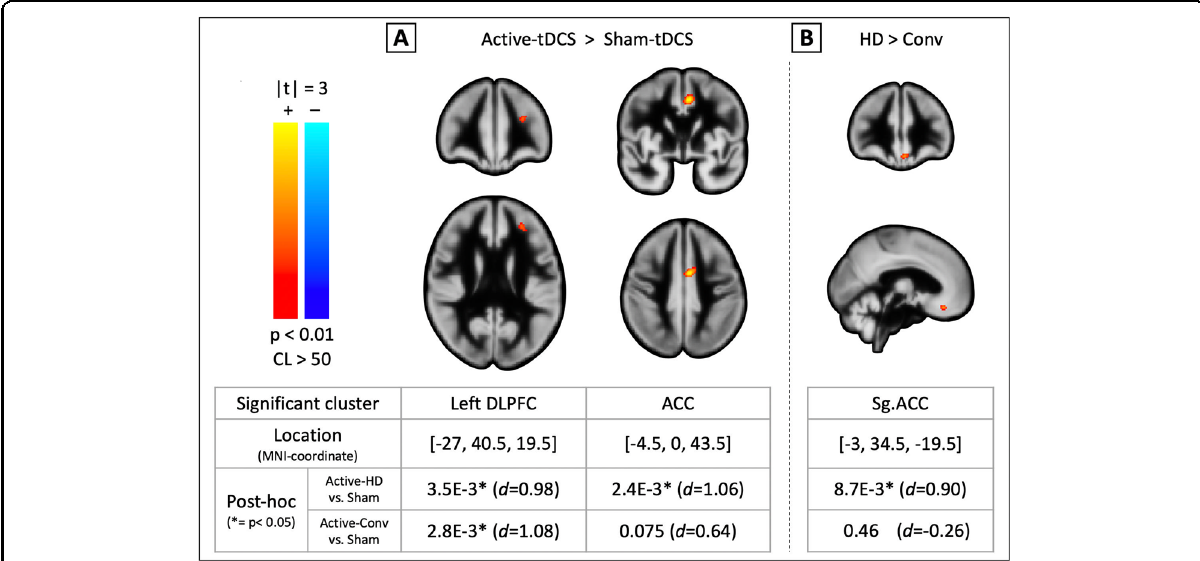
Fig. 4 tDCS treatment-induced changes in cerebral blood fl ow. A shows post-treatment CBF changes in the Active-stimulation group relative to Sham over the brain. Two signi fi cant clusters were observed ( p < 0.01, cluster-size > 50). The fi rst, at [ x = − 27, y = 40.5, z = 19.5] MNI coordinates, when compared to the stimulation target at [ x = − 46, y = 44, z = 38], is (a) 3.5 mm distance away in the coronal direction (i.e. <1/2FWHM used for spatial-smoothing), and (b) 44.2° in the coronal plane under the target; indicating that the observed cluster is located directly underneath the stimulation-target. Here, posthoc t -tests show that both montages induce a signi fi cant increase in CBF (relative to Sham) with large effect-sizes ( d Conv = 1.08, d HD = 0.98; p < 0.05 for both). The second cluster is located at [ x = − 4.5, y = 0, z = 43.5] MNI coordinates. Here, posthoc t -tests showed a signi fi cant effect for Active-HD with a large effect size, and a trending medium-to-large effect-size for Active-Conv compared to Sham ([HD]: d = 1.06, p = 2.4E − 3; [Conv]: d = 0.64, p = 0.075). Overall, these clusters are part of BA 46 in the left DLPFC and the ACC, respectively, which in turn are part of the prefrontal-limbic network (see Supplementary Fig. S7 for complementary anatomical-ROI analysis showing similar results). B shows montage-speci fi c CBF changes over the brain (Active-HD > Active-Conv). Here, a signi fi cant cluster was observed at [ x = − 3, y = 34.5, z = − 19.5] MNI coordinates in the subgenual-ACC. Follow-up posthoc t -tests showed a signi fi cant effect for Active-HD with a large effect size, and non- signi fi cant results for Active-Conv relative to Sham ([HD]: d = 0.90, p = 8.7E − 3; [Conv]: d = − 0.26, p = 0.46). Note that no signi fi cant clusters indicating differences in baseline-CBF were observed between the compared